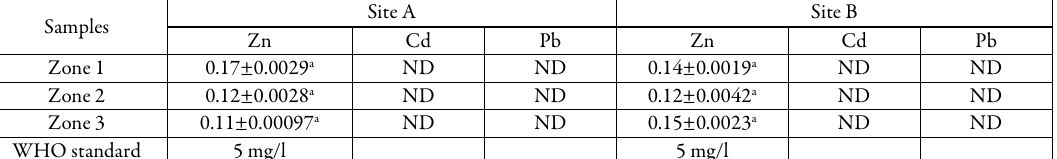
WHO standard 5 mg/l 5 mg/l NB: Mean±SD (in the same column) with same letters in superscripts were significantly same (P<0.05). ND implies not detectable.